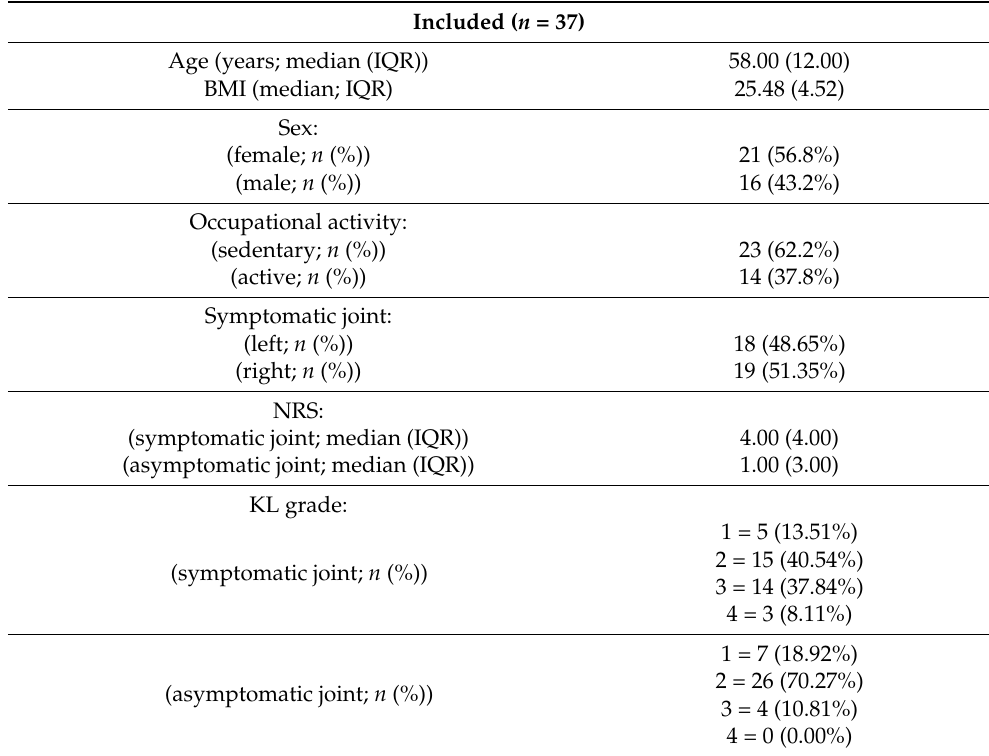
Table 2. Baseline